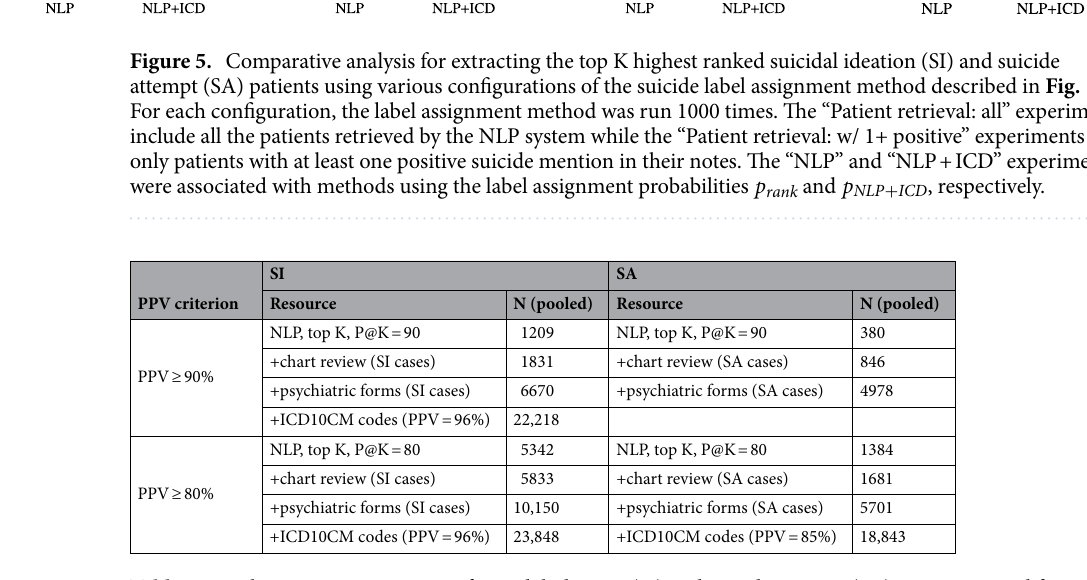
Table 4. High-precision extraction of suicidal ideation (SI) and suicide attempt (SA) cases extracted from the EHR.